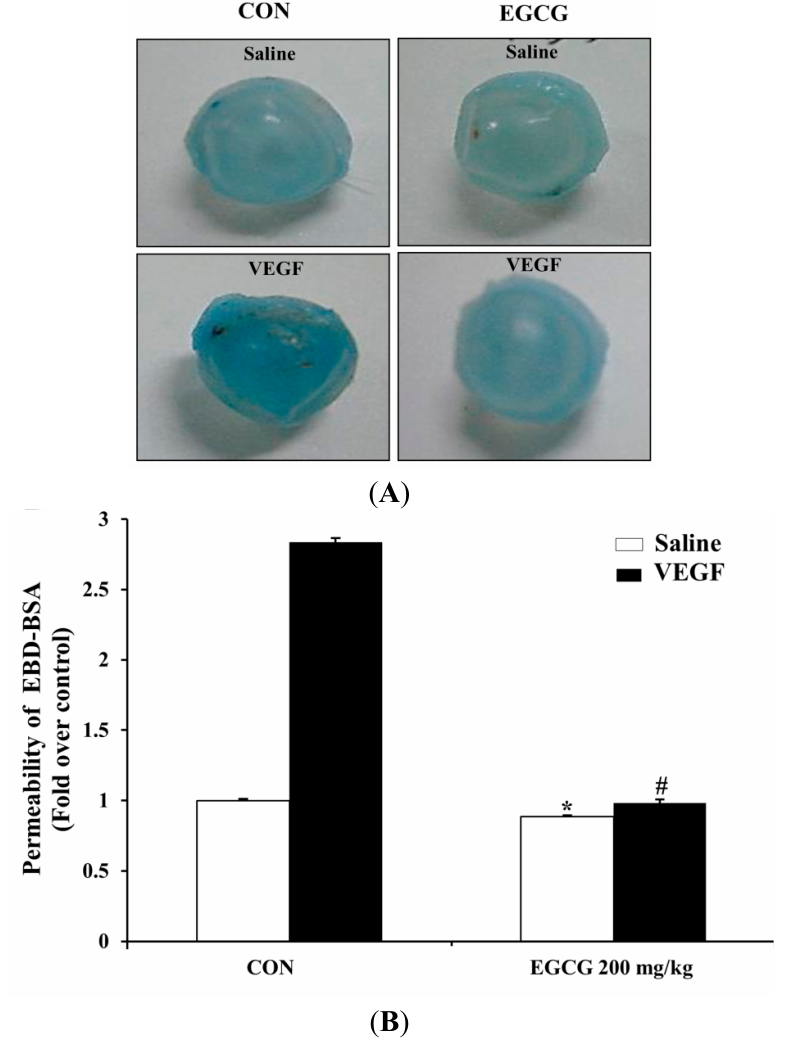
Figure 9. EGCG inhibits VEGF-induced vascular leakage by blood-retinal barrier breakdown in vivo . ( A ) VEGF induced vascular leakage of serum albumin-bound Evans Blue in the eyeball of rat administered orally with EGCG (200 mg/kg) or saline for 4 days. Figures were selected as representative photographs from three independent experiments; ( B ) Spectrophotometric analysis of vascular leakiness by formamide-extracted Evans Blue dye content. Evans Blue dye content of eyes injected intravitreally with VEGF (50 ng) after EGCG (200 mg/kg) orally pretreatment was significantly decreased compared with that of eyes injected with VEGF alone. The results are expressed as fold induction of control and are presented by mean ± SD (n = 6 mice per group). * , NS vs . saline treated in control group; #, p < 0.01 vs . VEGF treated in control